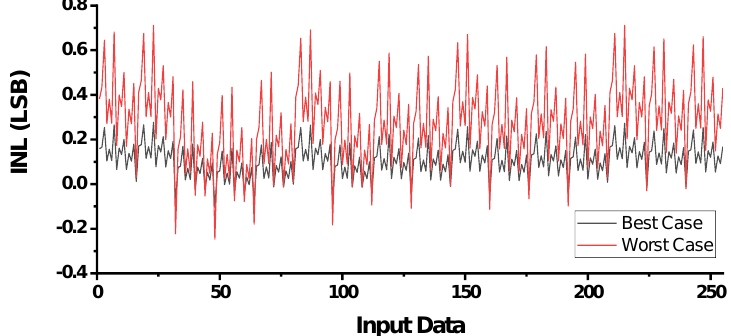
Figure 20. Simulated INL plot of best and worst case after auto PnR.